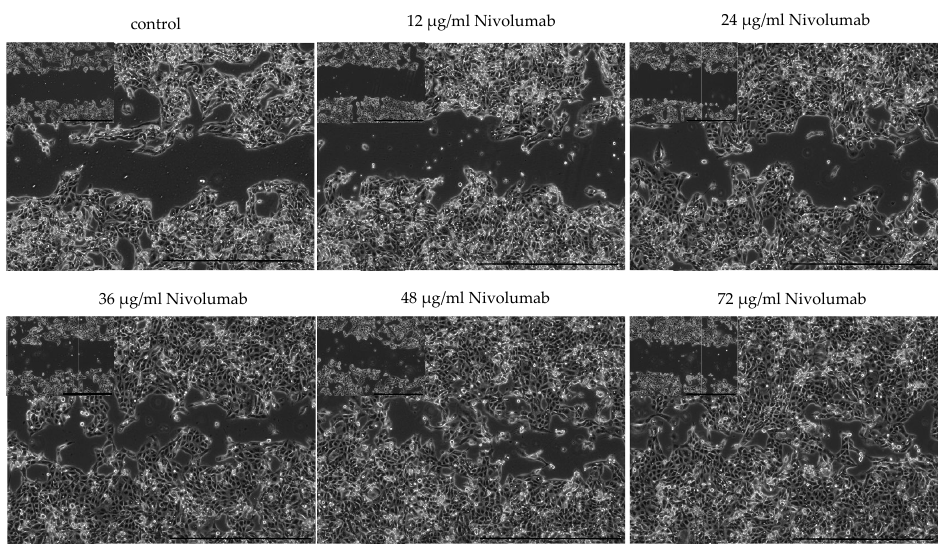
Figure 4. Motility of ACHN cells treated with nivolumab for 24 h; scale bars 1000 µm.